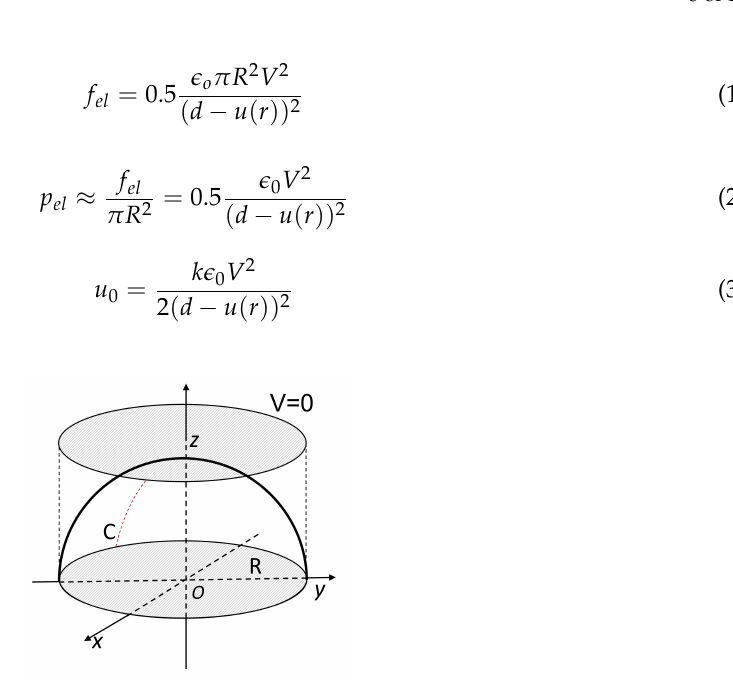
Figure 1. Representation of an electrostatic circular membrane MEMS device: the membrane is deformed towards the upper disk while the lower disk is at potential V =